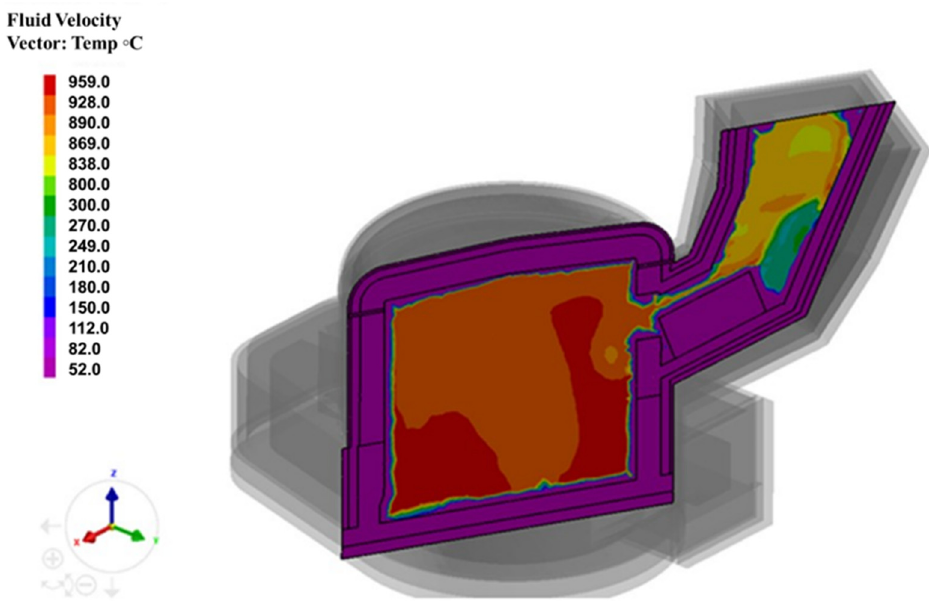
Figure 10. Temperature profiles inside the melting chamber and the melting tower, once three layers of insulating materials were built-up, after a simulation time of 5400 s.